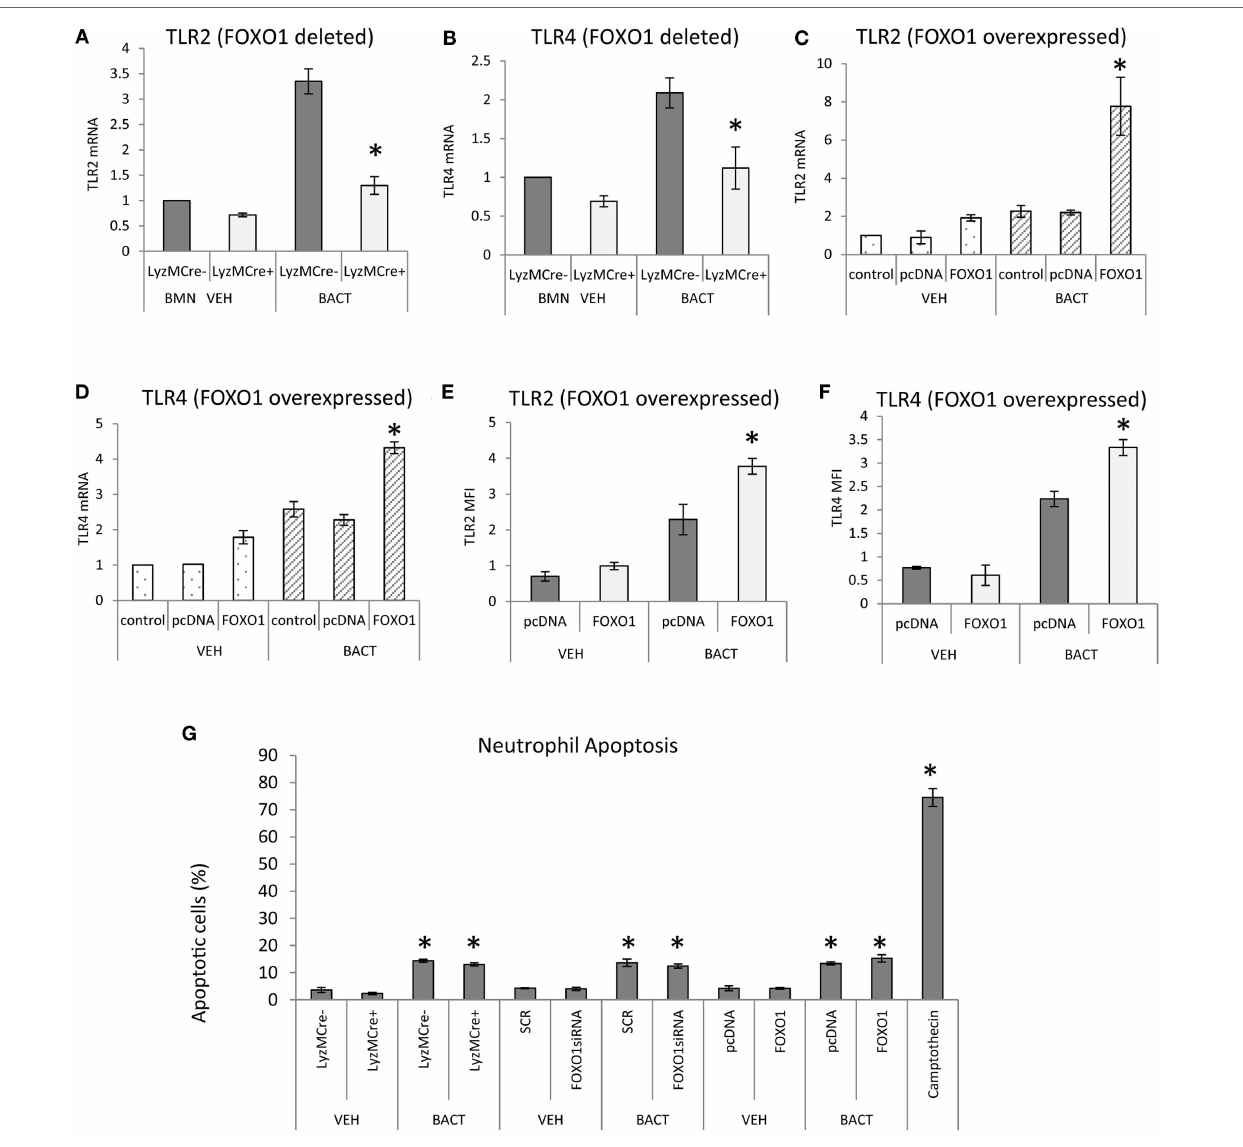
FigUre 6 | FOXO1 regulates TLR expression in neutrophils. (a,B) Bacteria were incubated with neutrophils from FOXO1-deleted LyzM.Cre + FOXO1 L/L and littermate control LyzM.Cre − FOXO1 L/L mice. RNA was isolated and mRNA levels of TLR2 and TLR4 were measured by RT-PCR and normalized to ribosomal protein L32. (c–F) HL-60 neutrophils were transfected with FOXO1 or empty vector alone and stimulated with bacteria or vehicle alone. RNA was isolated and real-time PCR was carried out to assess mRNA levels of TLR2 and TLR4 or immunofluorescence was carried out with antibody specific for TLR2 or TLR4 and protein levels